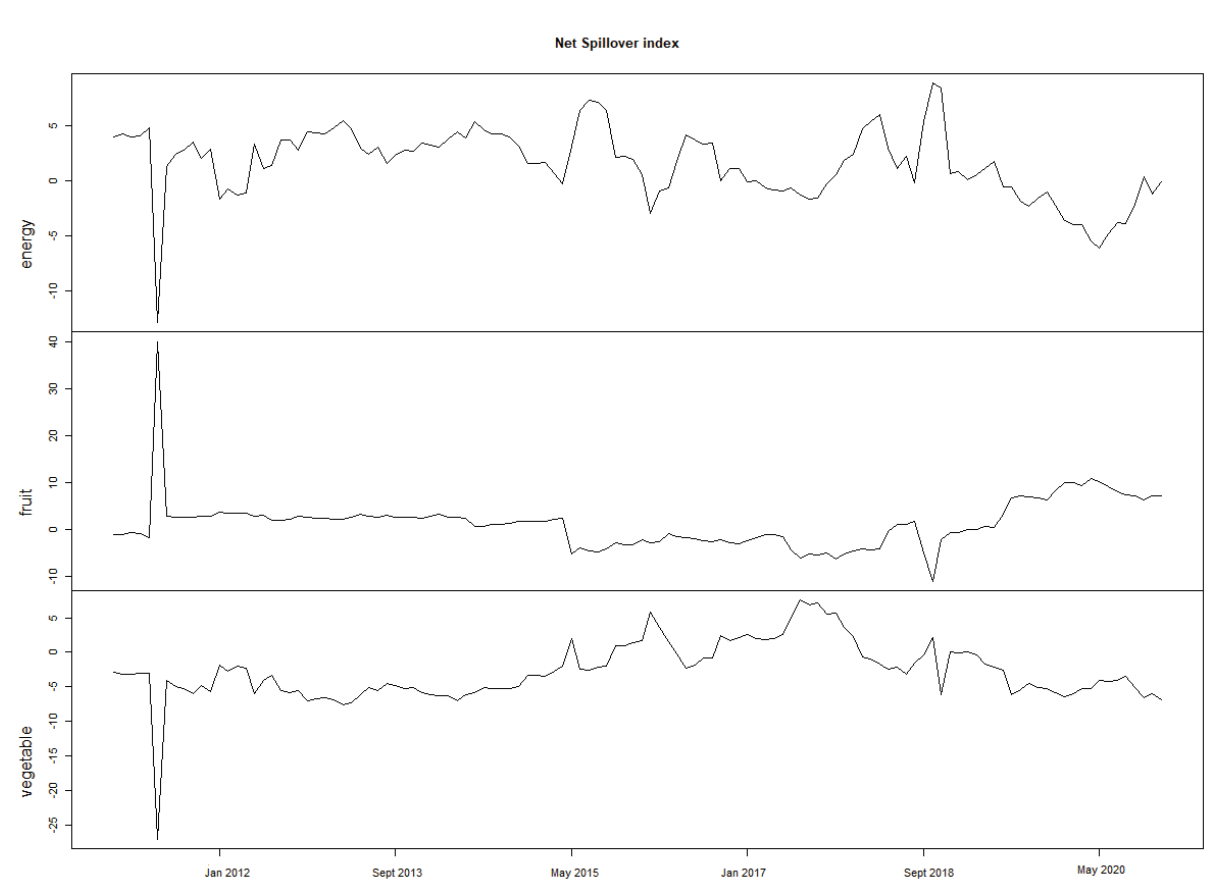
Figure 3. The Top-Down Rolling Net Spillovers Indexes for EPI, FPI and